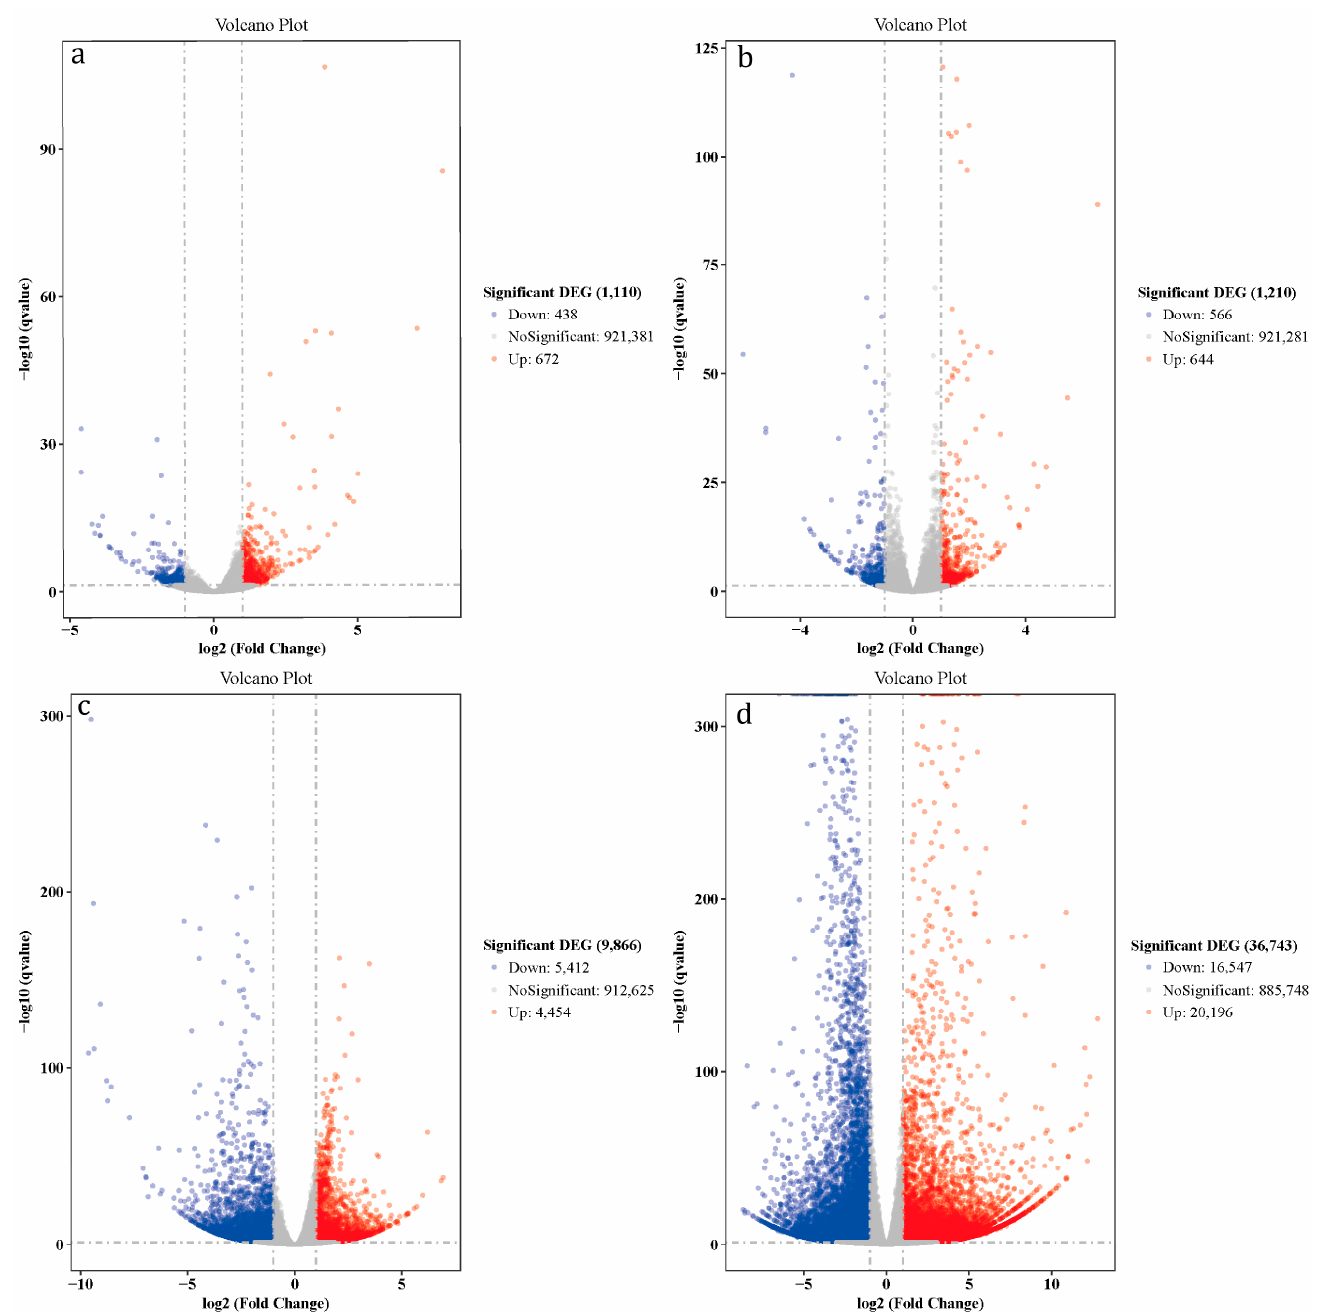
(bx4 vs. ck4) (Figure 4d). In addition, with the prolongation of keep-fresh time, the number of DEGs also increased (see data in Supplementary Material S2: DEGs.xlsx).